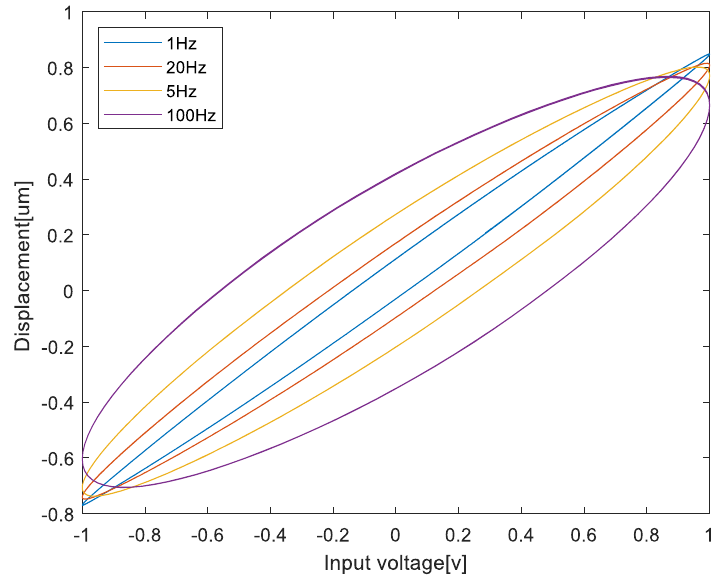
Figure 1. Hysteresis nonlinearity of PEA.